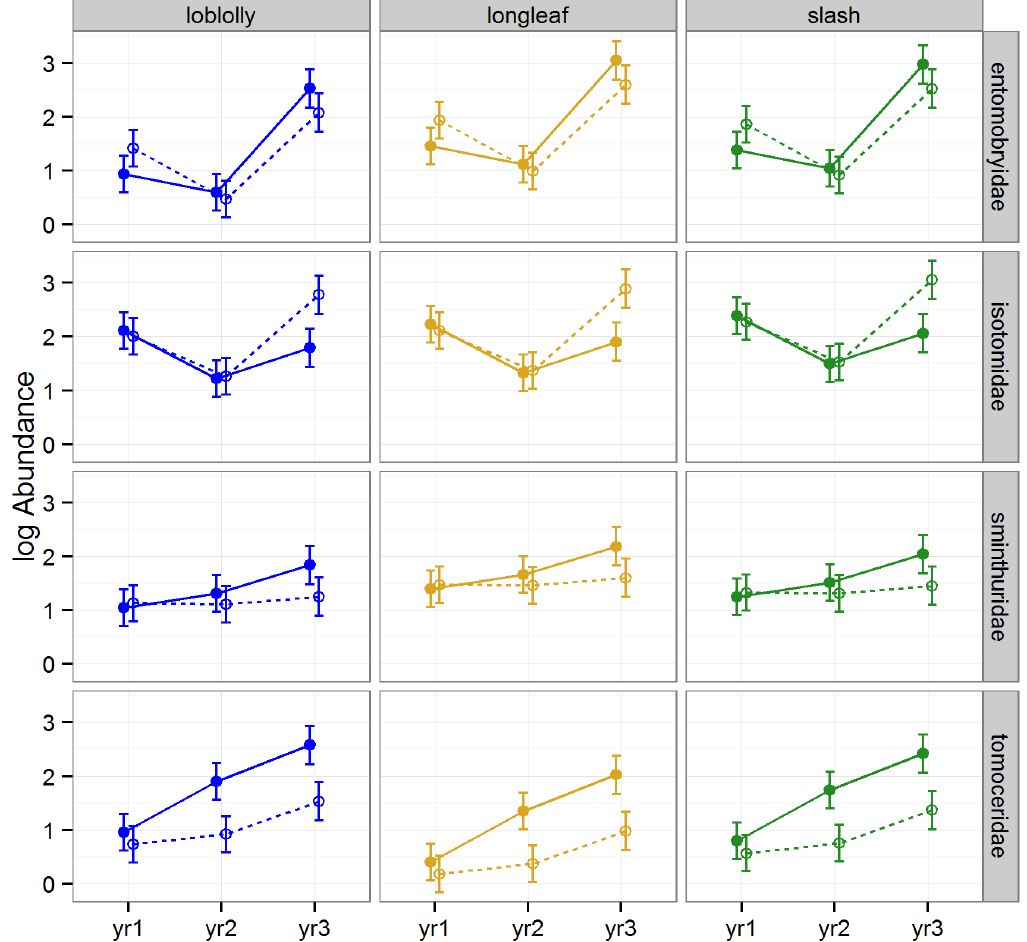
during three years of seasonal pitfall trapping in pine plantations in North Florida against fixed effects from the most parsimonious model based on log-likelihood ratio tests; raked stands are displayed with open circles and dashed lines, intact stands with solid circles and lines; 2008 as yr1, 2009 as yr2, and 2010 as